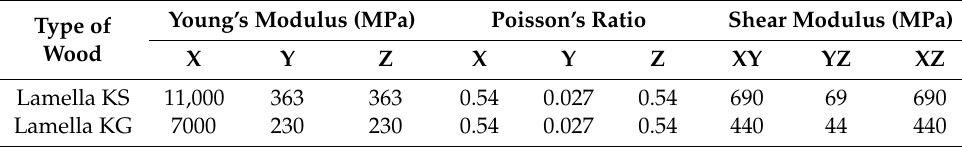
Table 3. Timber material